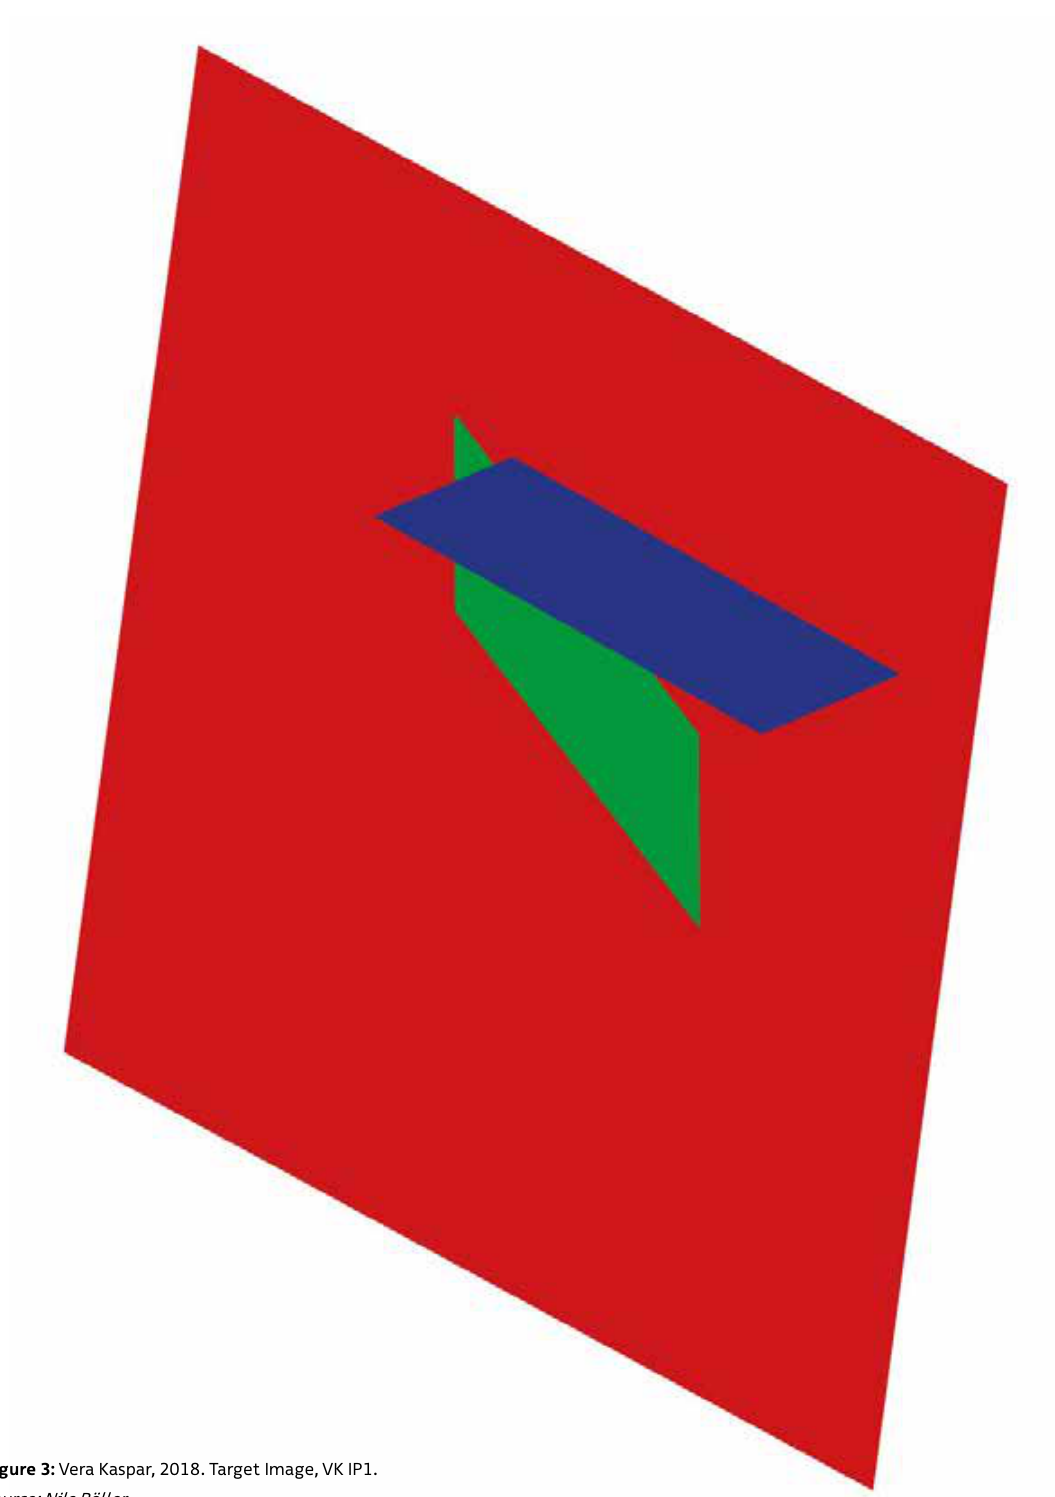
Figure 3: Vera Kaspar, 2018. Target Image, VK IP1. Source: Nils